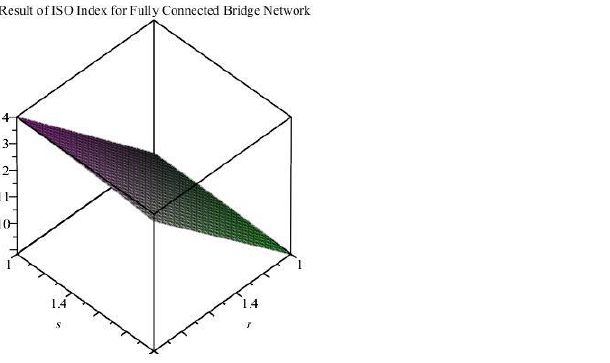
Figure 6. Result of ISO index for bridge network of multiple fully connected mesh.